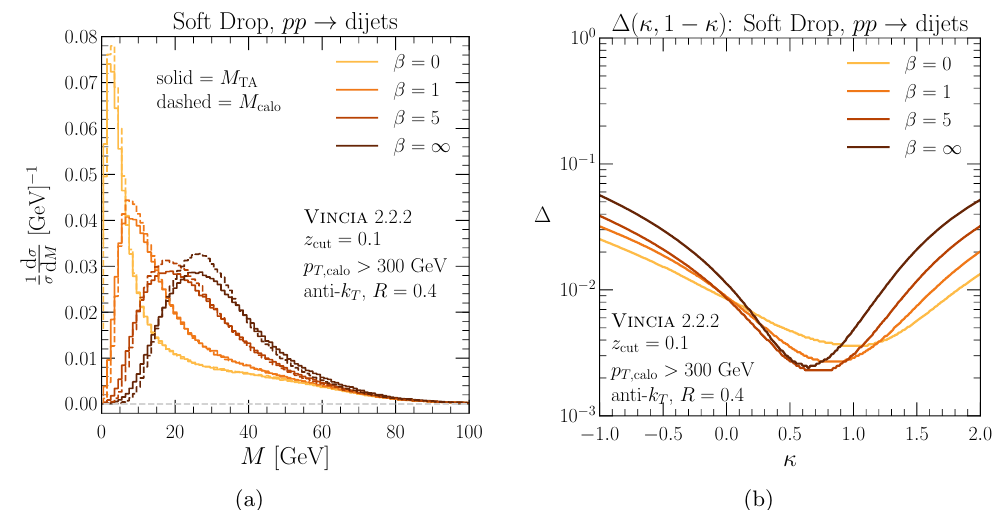
Figure 15 . (a) Groomed jet mass and track-assisted mass distributions in Vincia for z cut = 0 : 1 and various values of (cid:12) . The (cid:12) = curve corresponds to the ungroomed distribution. (b): the 1 statistic (cid:1)( (cid:20); 1 (cid:20) ) for the same values of (cid:12) (cid:0)